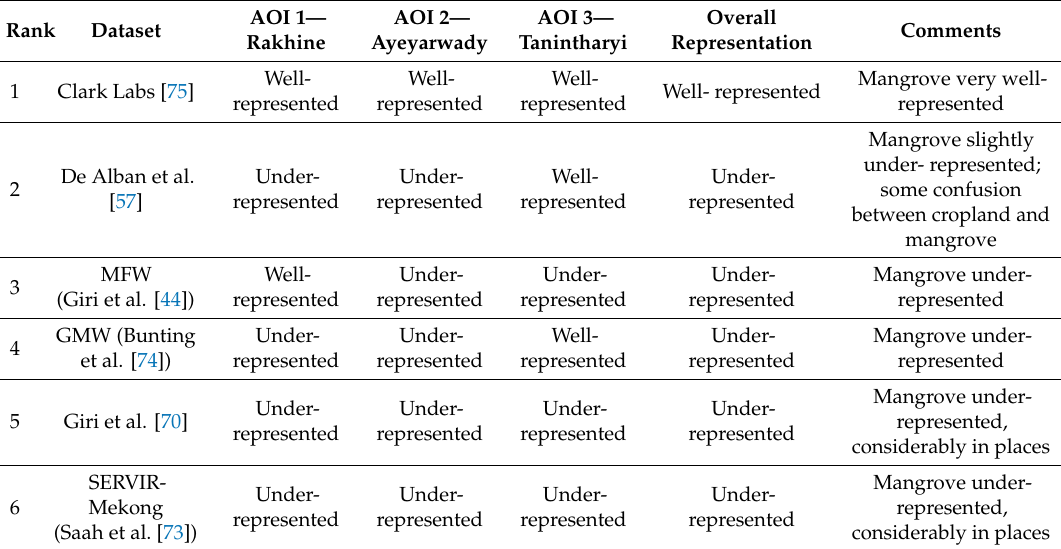
Table 6. Results of QAA for available / acquired datasets (1 =